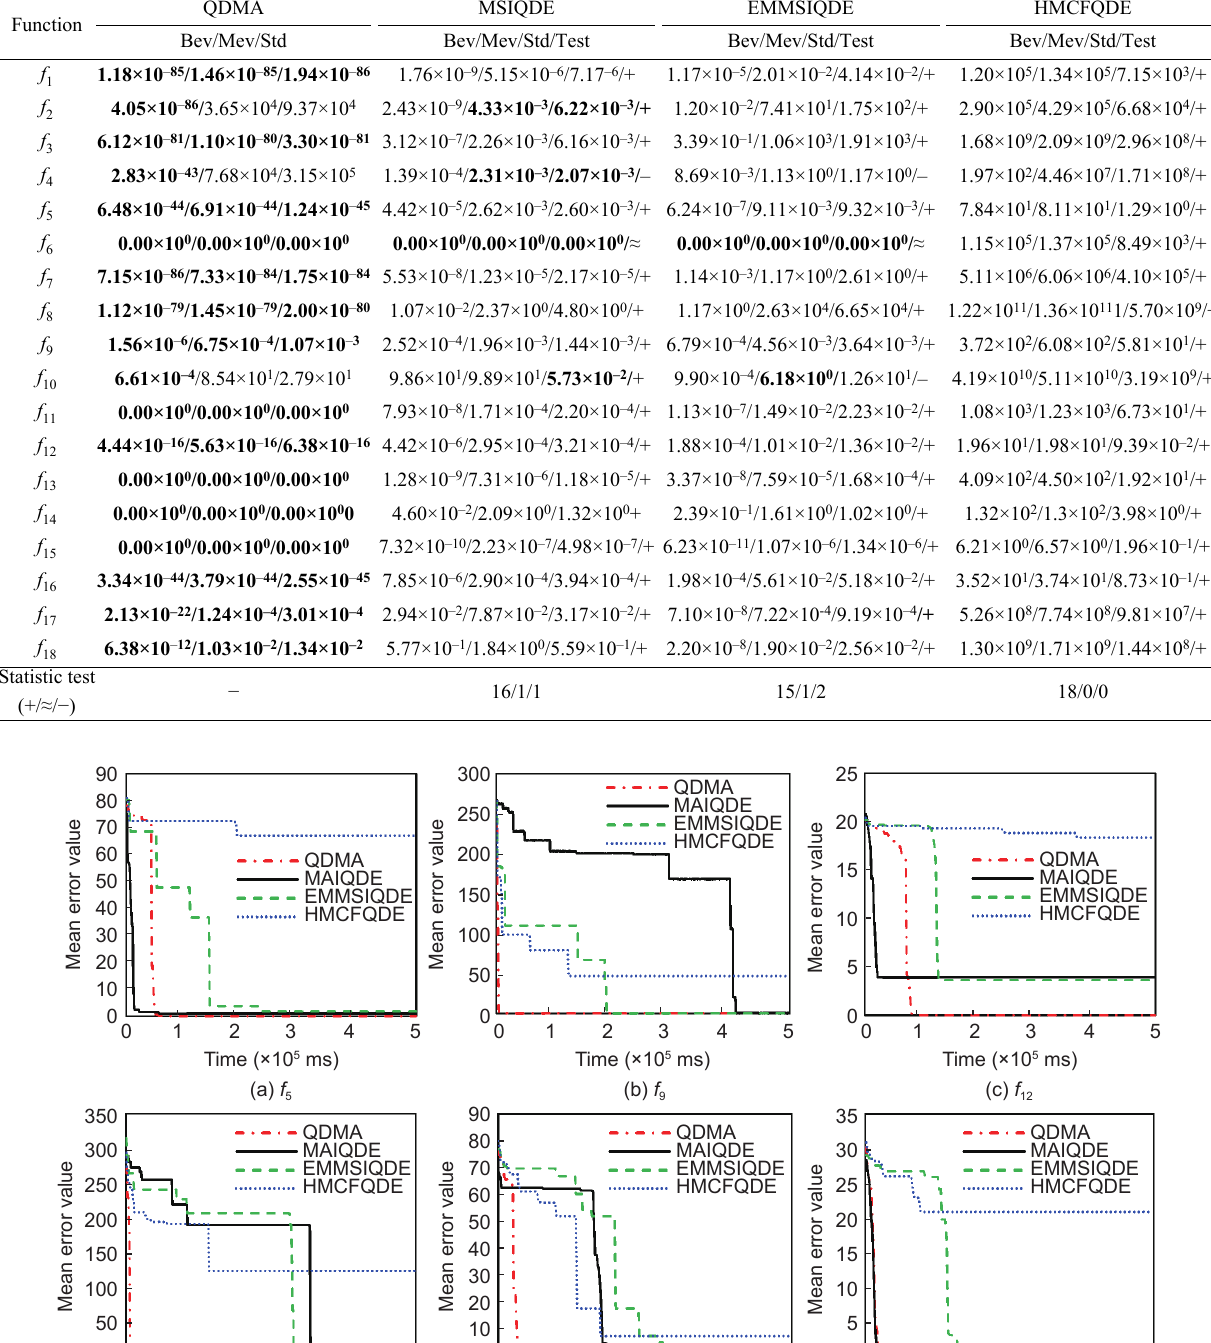
Table 4 Comparison of QDMA and state-of-the-art QEAs on 100 D problems.